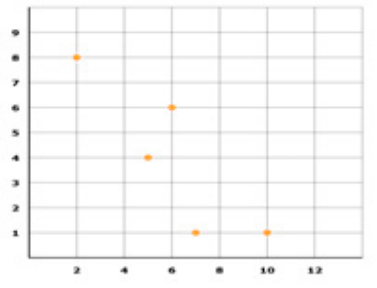
Figure 4. The graph by S9.